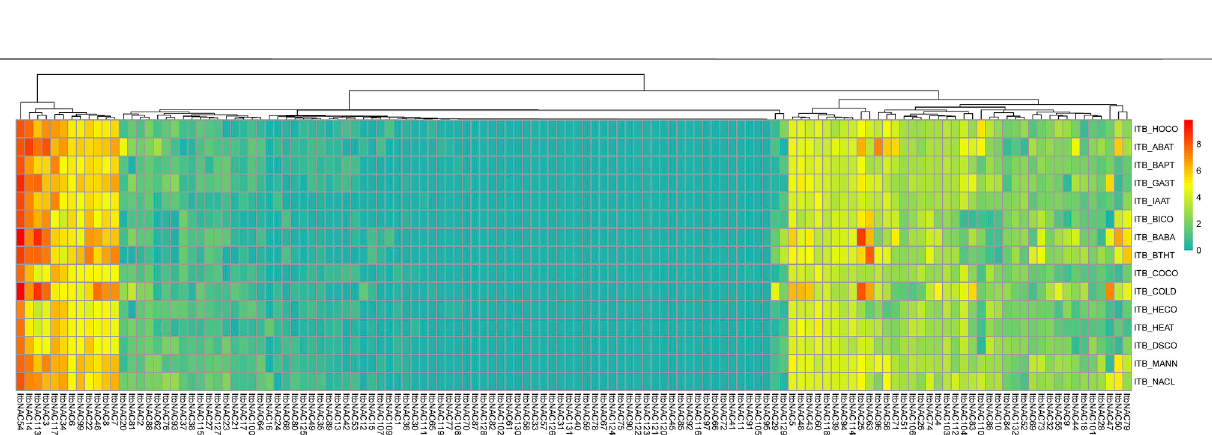
FIGURE 8 | Expression patterns of ItfNAC genes in fi ve tissues ( fl owers, fl ower buds, leaves, roots and stems) in the wild sweet potato Ipomoea tri fi da. The transcript abundance in different tissues was examined using RNA-Seq gene expression data. Expression pro fi les via a heat map were calculated from the log2 (FPKM+1) value, and shown as a blue-yellow-red gradient by using the heat map package in R version 3.4.0.